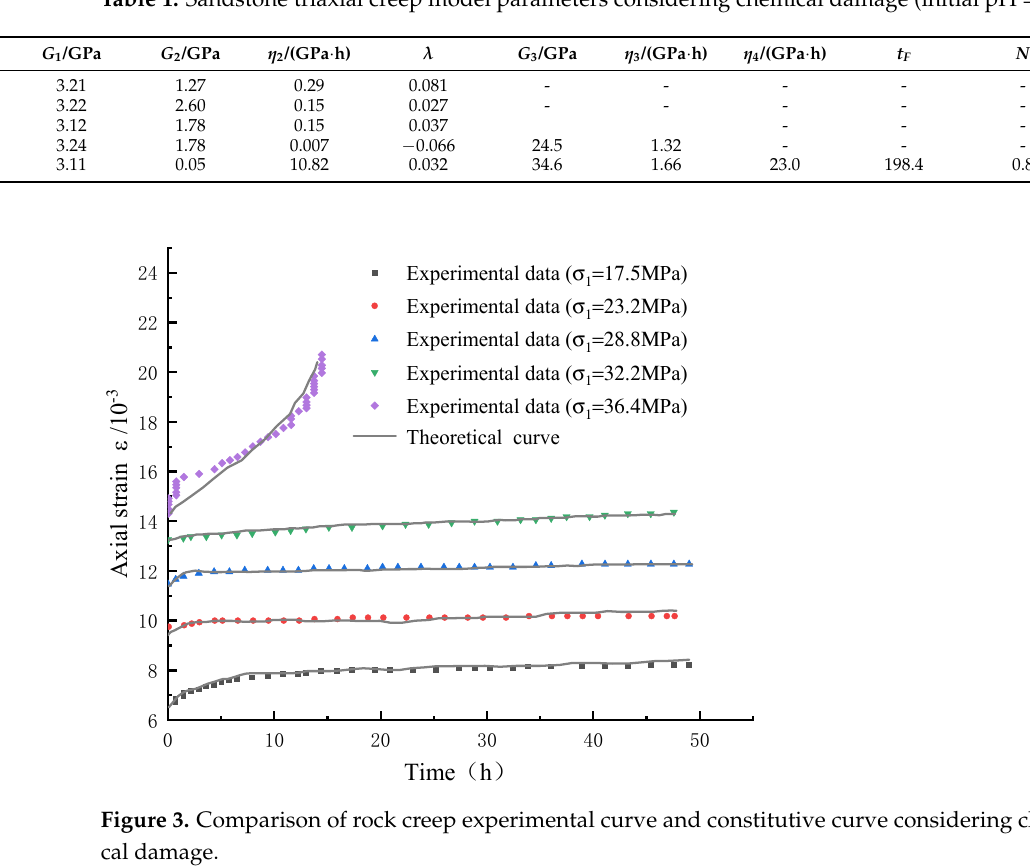
Table 1. Sandstone triaxial creep model parameters considering chemical damage (initial pH = 3).